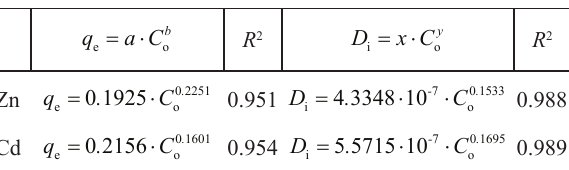
ion removal onto